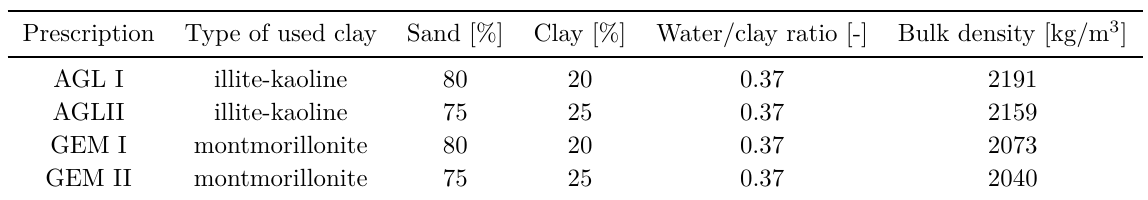
Table 3. Prescriptions of used specimens and bulk densities of final specimens.